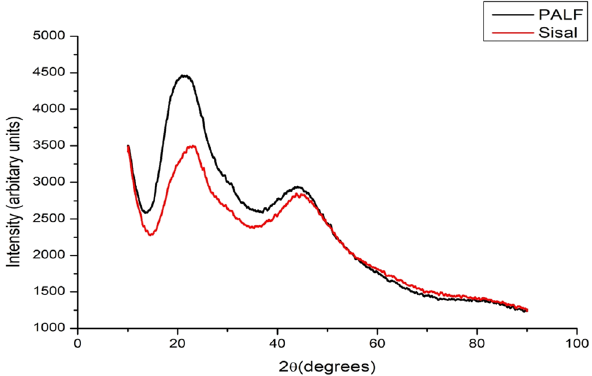
Figure 5: XRD analysis of PALF and sisal fi ber